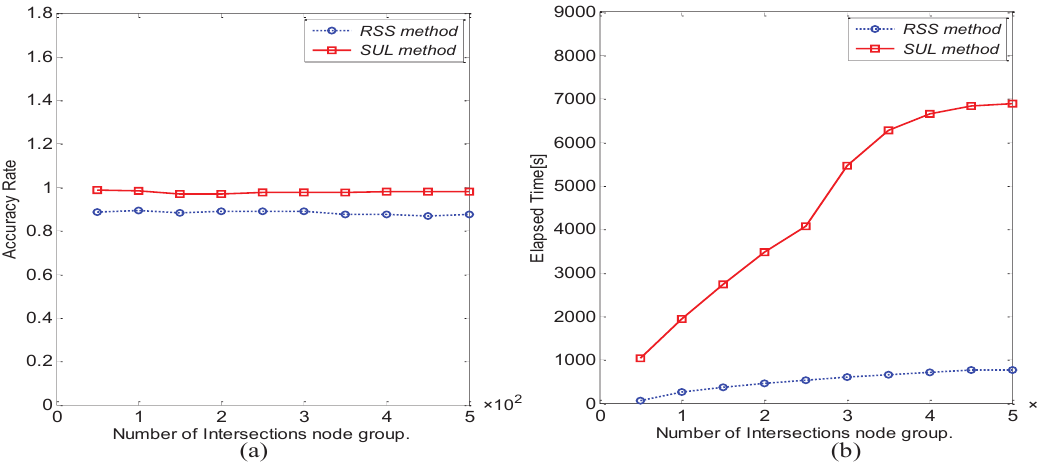
Figure 10. Comparison between the RSS method and the SUL method. ( a ) For key nodes accuracy rate; ( b ) For elapsed time.